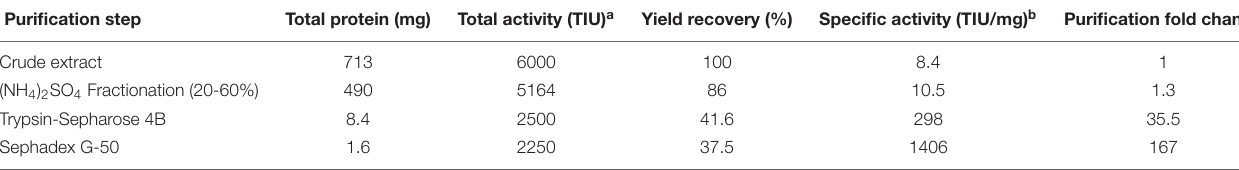
FIGURE 1 | Purification profile of PnBBI and its in-gel activity. Elution profile of (A) trypsin-Sepharose 4B column loaded with 20-60% (NH 4 ) 2 SO 4 active fraction; (B) Sephadex G-50 fine column loaded with active peak II fraction pool of trypsin affinity column; (C) Tricine SDS-PAGE (15%) showing purification profile and self-association pattern of PnBBI: lane 1, molecular weight marker designated in kDa; lane 2, peanut crude protein extract (20 µ g); lane 3, 20-60% (NH 4 ) 2 SO 4 protein fraction (15 µ g); lane 4, active fraction pool (Peak II) of trypsin affinity column (10 µ g); lanes 5-7 and 8-10 active fraction pool (peak II) of gel filtration column under non-reducing and reducing conditions with increased protein concentration (2.5, 5, and 10 µ g), respectively; lane 11, soybean BBI (5 µ g) was used as a reference. Gelatin SDS-PAGE (15%): Lane 1, soybean BBI (5 µ g); lane 2, PnBBI (5 µ g) active against (D) bovine pancreatic trypsin and (E) chymotrypsin, respectively. Asterisks indicate active peak with inhibitory activity against trypsin. M-monomer, D-dimer and T-tetramer. The data shown here is the representative of three biological replicates (data provided as Supplementary Data Sheet 3 ). TABLE 1 | Purification of PnBBI from mature seeds (10 g) of peanut interspecific advanced variety